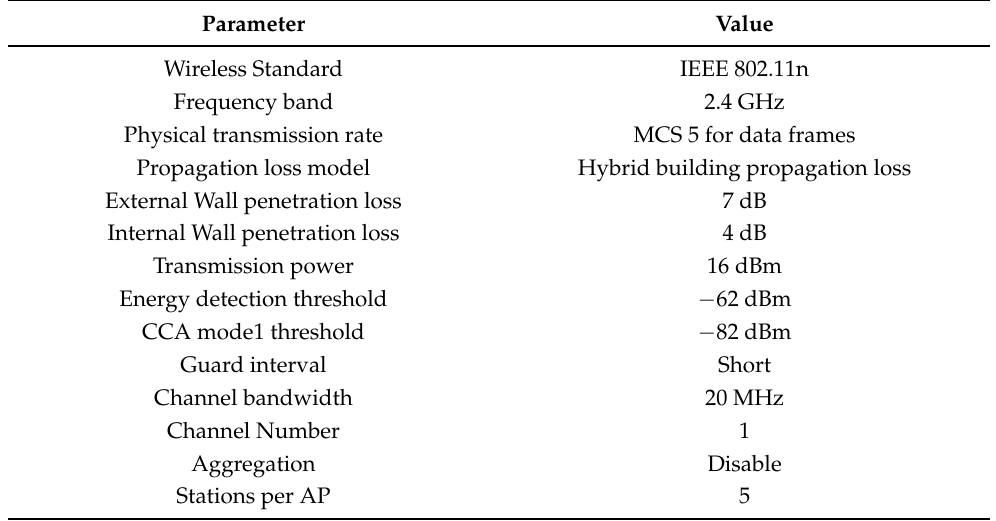
Table 5. Physical layer parameters for simulation.